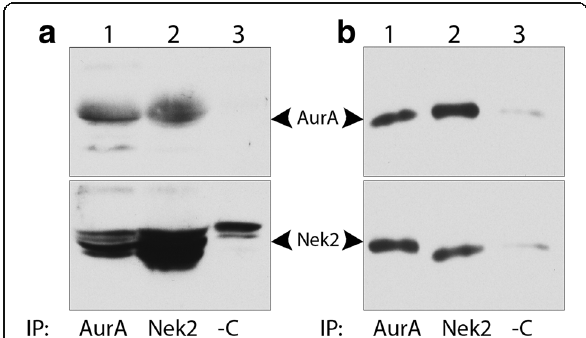
Fig. 3 Nek2 and AurA form a complex in ARPE-19 cells. ( a ) Cells were cotransfected with plasmids expressing AurA and Nek2 and cell lysates immunoprecipitated with either AurA antibodies (lane 1), Nek2 antibodies (lane 2), or no antibody (land 3) and probed for either AurA or Nek2. ( b ) Untransfected ARPE-19 cell lysates were immunoprecipitated with either AurA (lane 1), Nek2 (lane 2), or no antibody and probed for either AurA or Nek2. Each immunoprecipitate was blotted for the immunoprecipitating antibody to verify immunoprecipitation